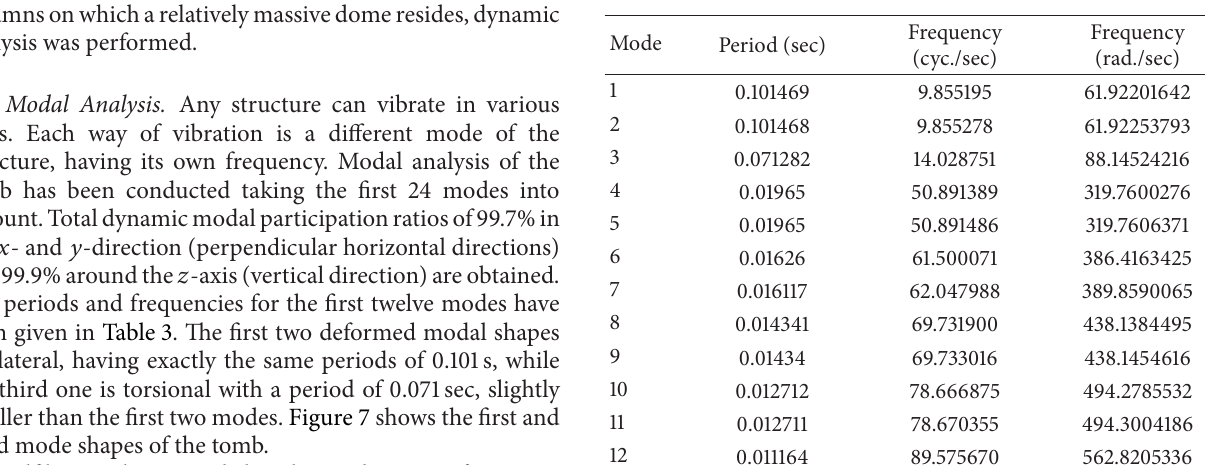
Table 3: First twelve vibration periods and frequencies of the